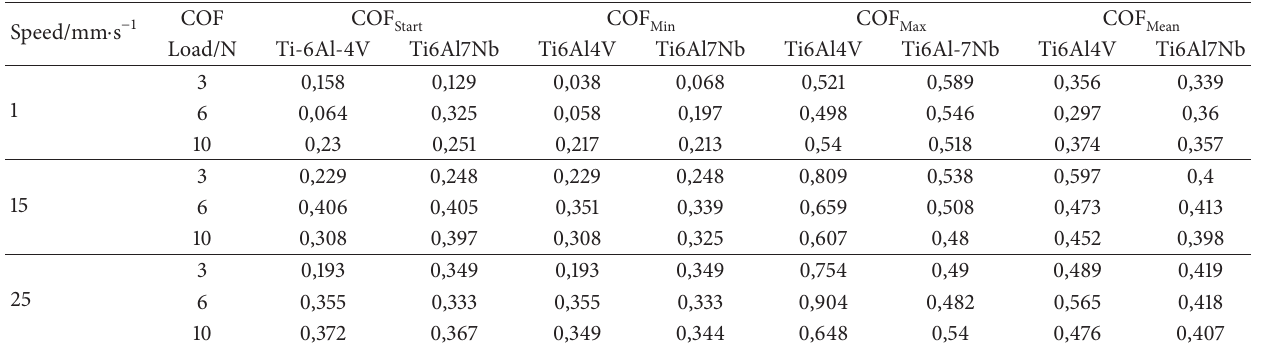
Table 4: Friction coefficient of Ti-6Al-4V and Ti-6Al-7Nb alloy at 1mms −1 sliding speed (after running in distance).